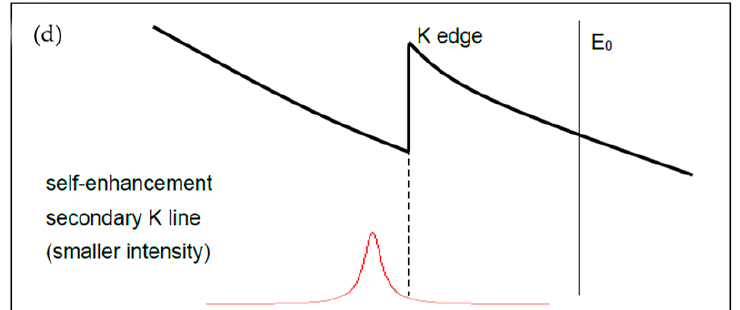
Figure 2. The figure shows the approximations used to describe the effects of Lorentzian distribution of the characteristic lines. The excitation of energy E 0 gives rise to the emission of the complete K series of XRF lines. For simplicity, only one line is shown here. ( a ) The Lorentzian-shaped characteristic line and the attenuation coefficient are plotted on the same graph. It is apparent that the right tail of the continuous distribution exceeds the energy of the K edge, producing the effects explained in the next two panels. ( b ) The emitted line is heavily attenuated by the K edge-jump on the right side of the edge. Therefore, a first-order approximation may assume a truncated Lorentzian line. ( c ) The right tail of each K line exceeding the edge energy can be absorbed to produce again the emission of the complete K series (self-enhancement process). The total self-enhancement correction is given by the addition of all these contributions. ( d ) A single line is shown of the secondary series emitted by self-enhancement. The intensity is small because the process is second-order.